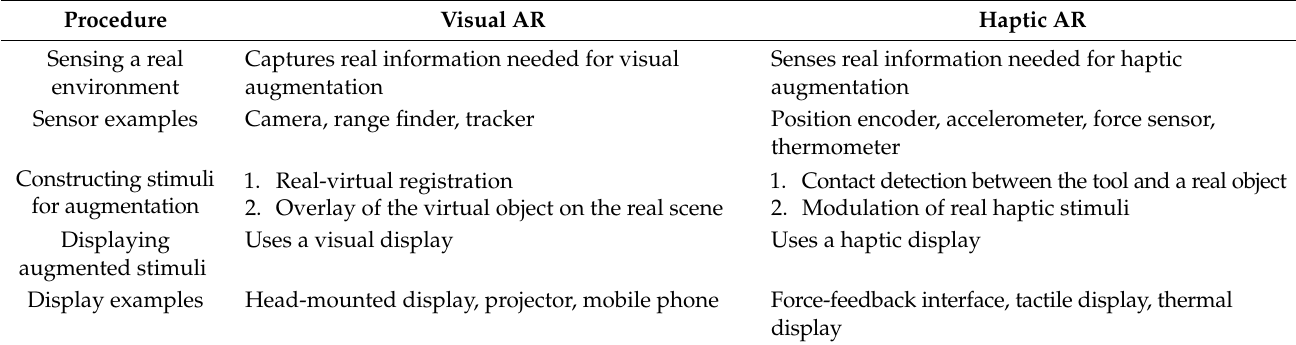
Table 3. Computational procedures of visual and haptic AR [20].